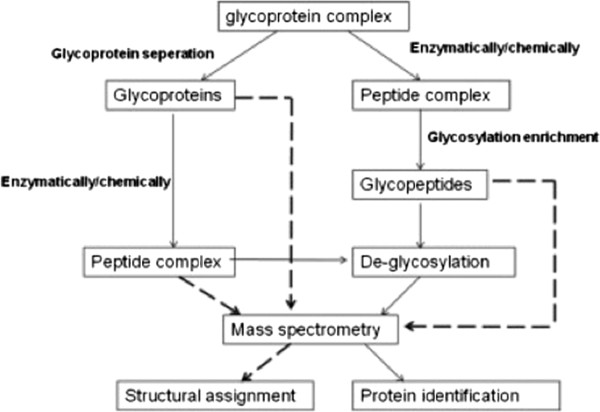
Typical workflow for glycoproteomics analyses [1].